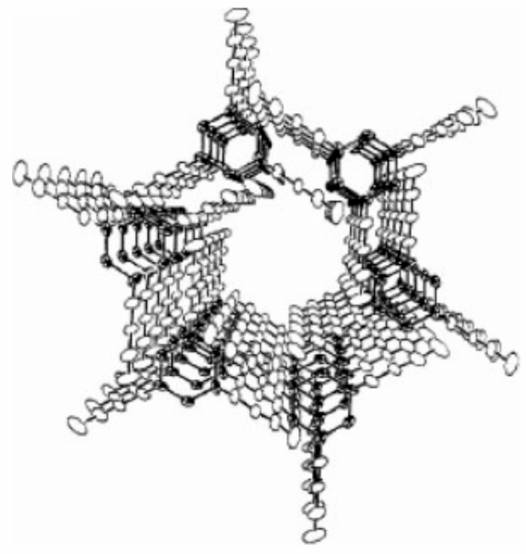
Figure 2. Schematic perspective view down one channel that penetrates the hexagonal crystalline lattice of tris(o-phenylenedioxy)cyclotriphos-phazene (TPP). Reproduced with permission from [10]. Copyright 1985 American Chemical